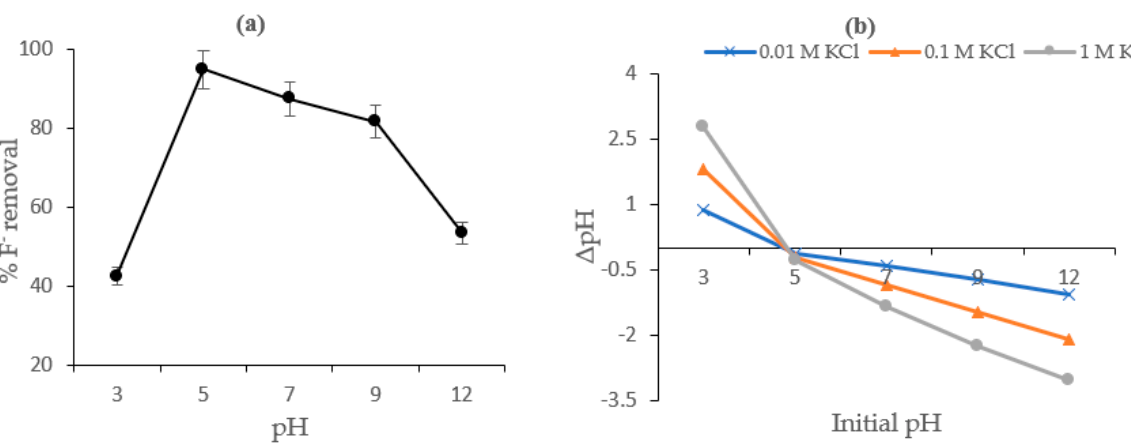
Figure 8. ( a ) Effect of initial solution pH; ( b ) pH pzc of CNF-AgMgOnHaP (adsorbent dose: 0.25 g volume of solution: 25 mL, contact time: 24 h at 150 rpm). volume of solution: 25 mL, contact time: 24 h at 150